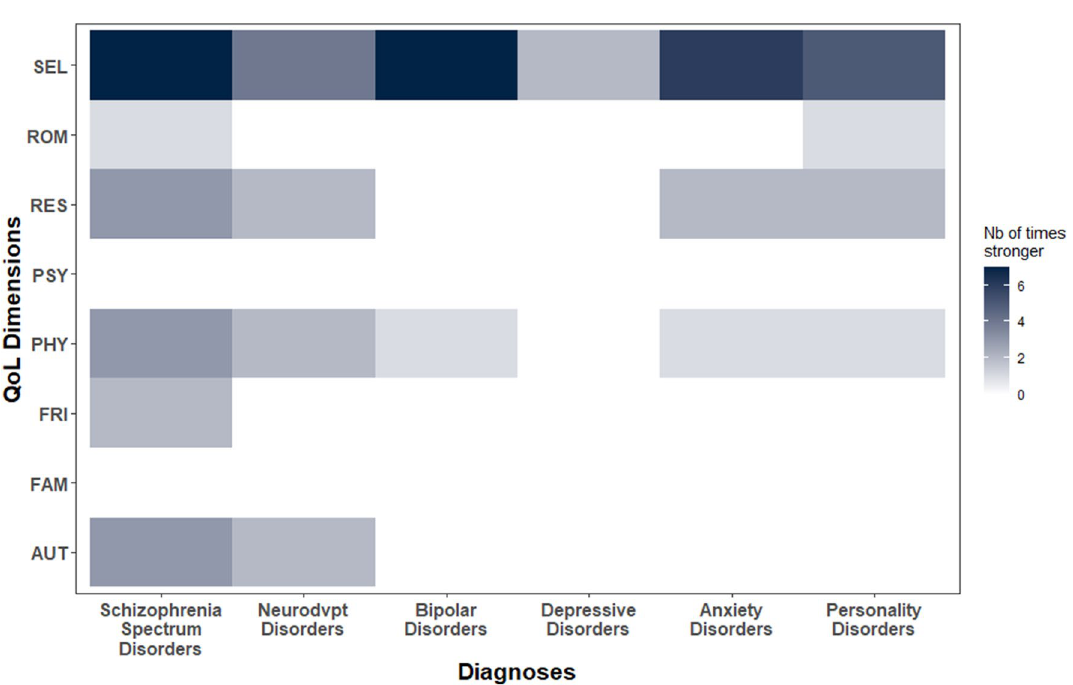
Figure 4. Relative importance of quality of life dimensions (nodes) among the six diagnosis groups. For each diagnosis group (X axis), each tile represents the number of times each node (Y axis) shows significantly greater strength than other nodes. Nodes (Quality of life dimensions; Y axis): SEL self-esteem, ROM romantic life, RES resilience, PSY psychological well-being, PHY physical well-being, FRI relationships with friends, FAM family relationships, AUT